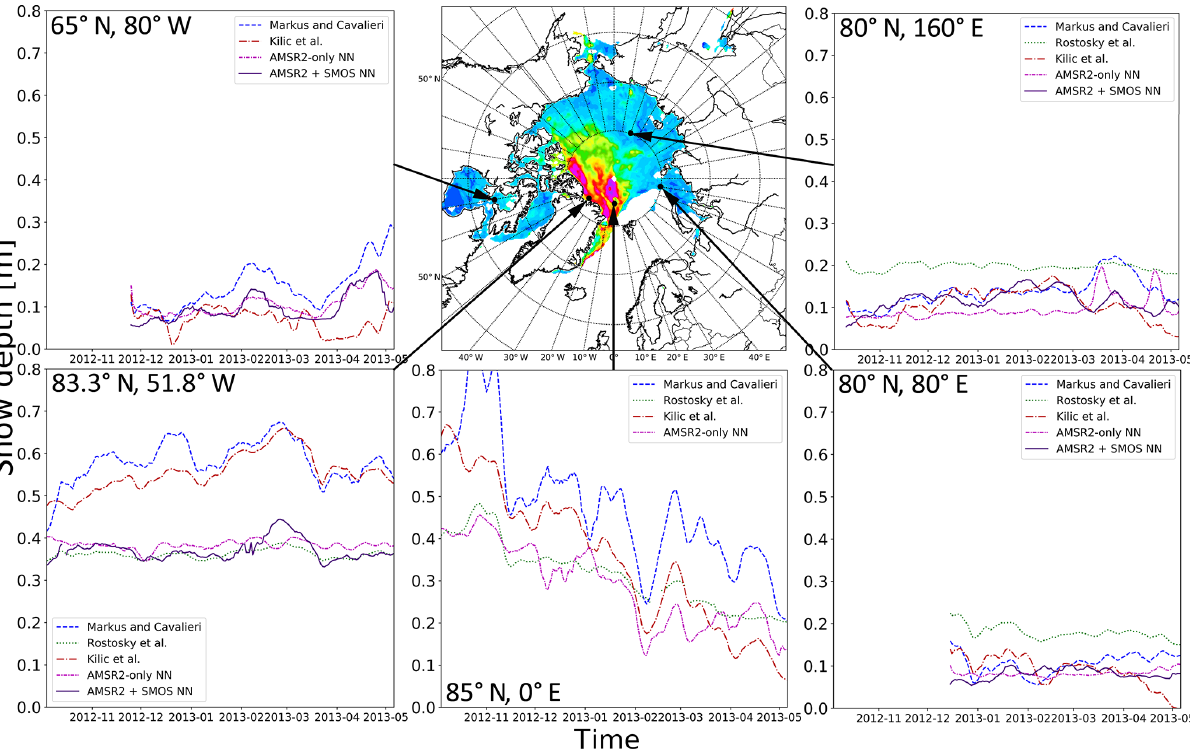
Figure 8. Time series of snow depth over one winter season 2012/2013 at different locations in the Arctic. The different algorithms are represented by different colours and lines. Snow depth on FYI in lower latitudes is only recorded once SIC has reached